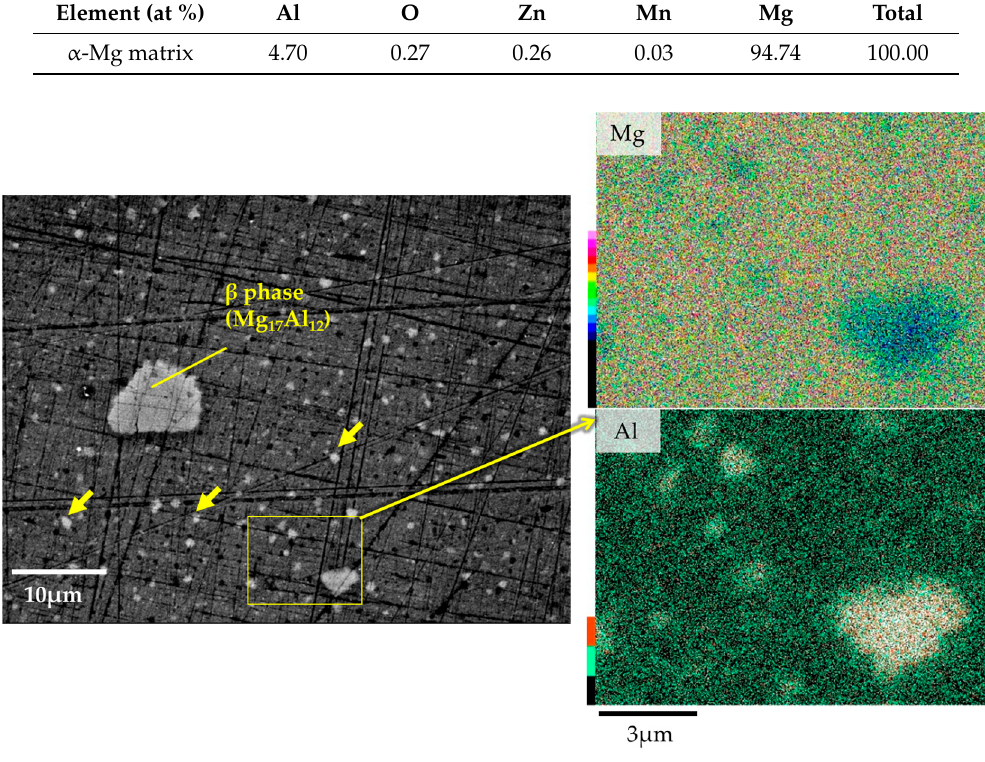
Figure 5. SEM-EDS analysis results of AZ61B powder precursor with no CaO particle after aging heat treatment at 200 °C for 86.4 ks in vacuum.